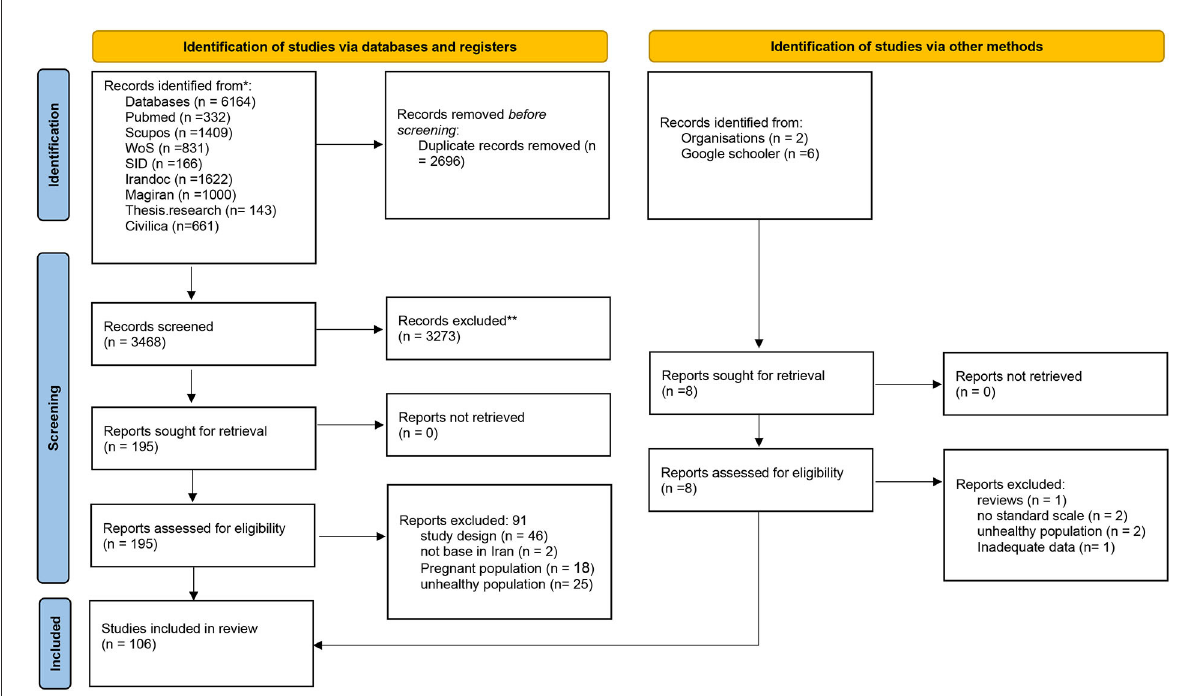
FIGURE1 PRISMA flow diagram for study selection from: Page et al. (23). For more information, visit: http://www.prisma-statement.org/.